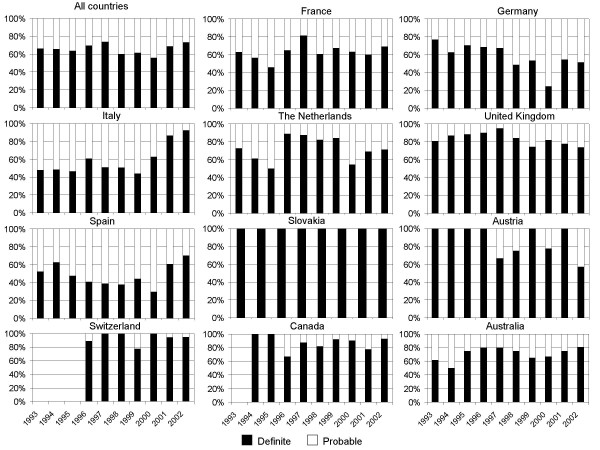
Annual proportion of histopathologically-confirmed, i.e. definite, sporadic CJD in EUROCJD countries.